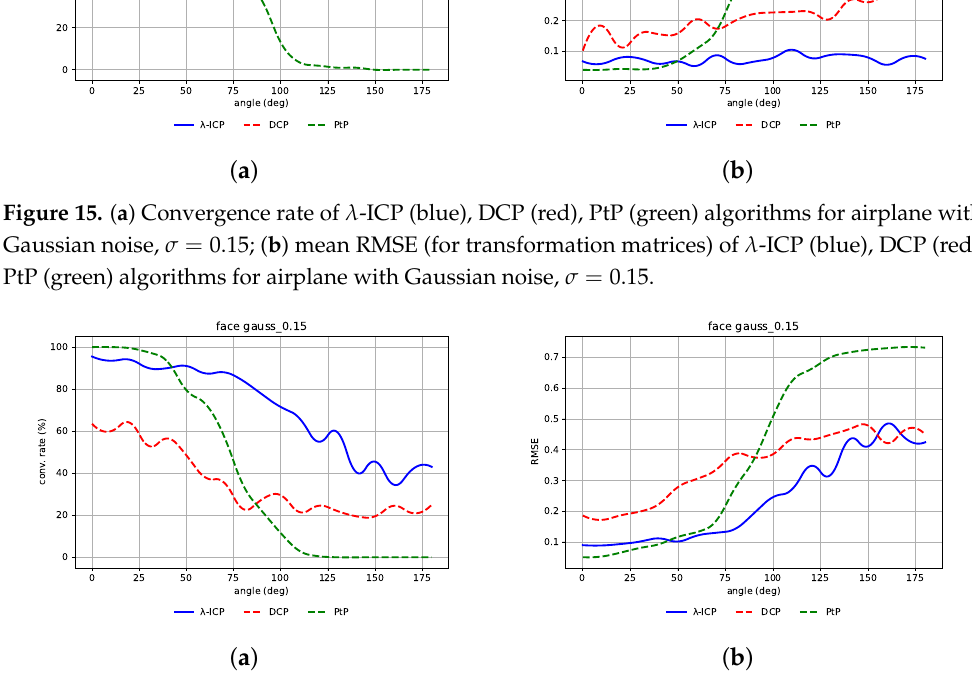
Figure 16. ( a ) Convergence rate of λ -ICP (blue), DCP (red), PtP (green) algorithms for human face with Gaussian noise, σ = 0.15; ( b ) mean RMSE (for transformation matrices) of λ -ICP (blue), DCP (red), PtP (green) algorithms for human face with Gaussian noise, σ = 0.15.